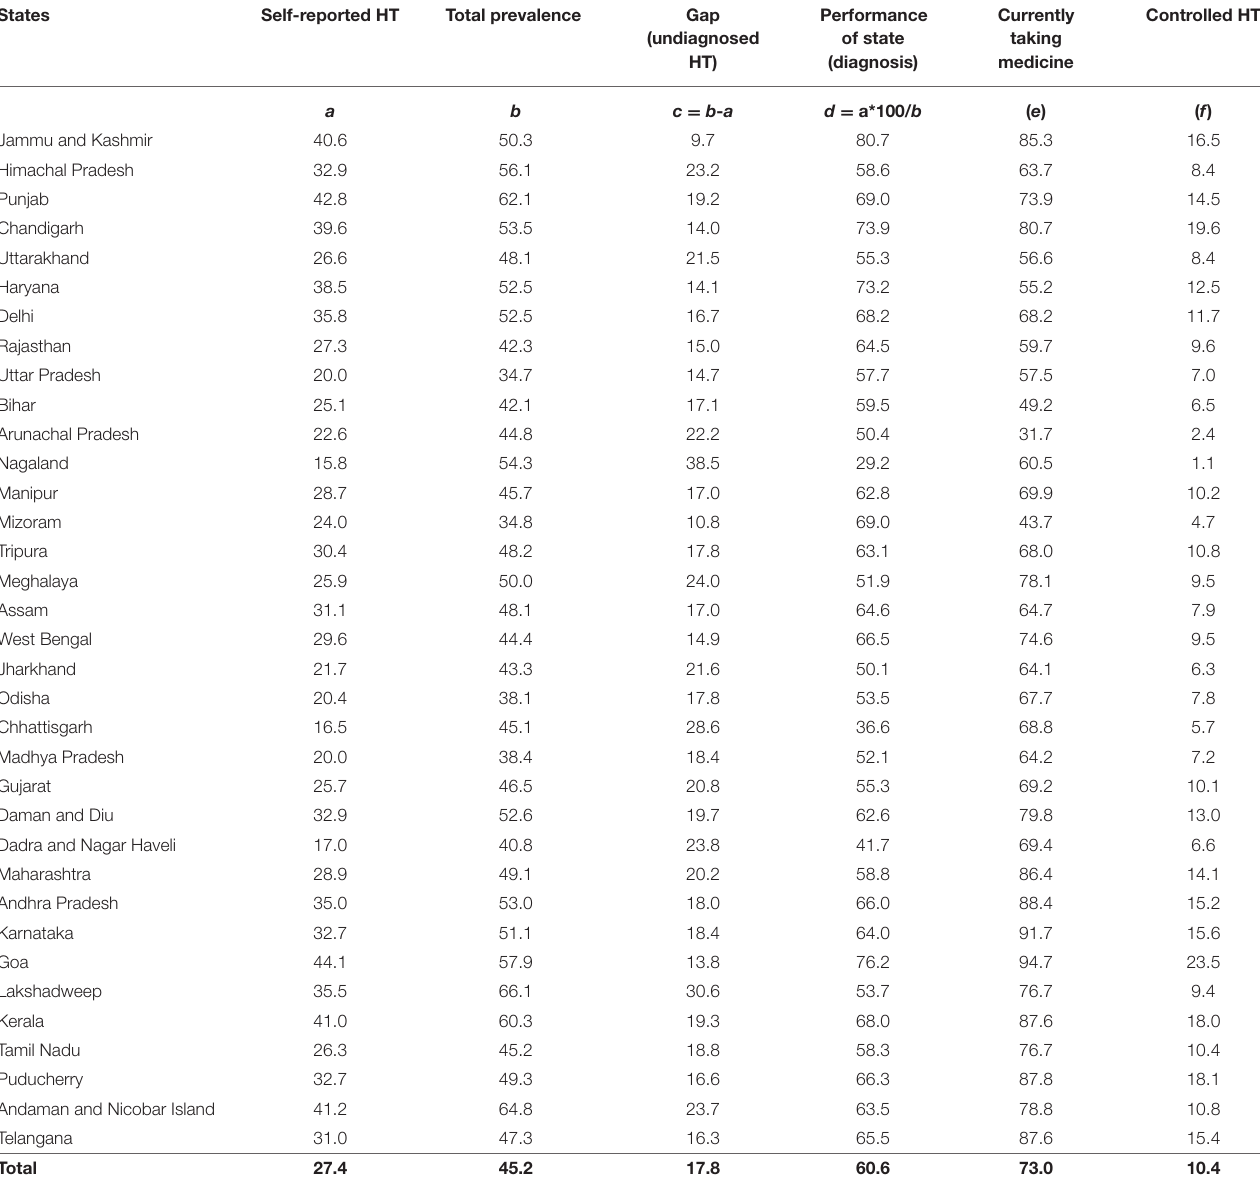
TABLE 4 | State-wise prevalence of self-reported, undiagnosed, overall, and controlled hypertension among older adults in India, LASI, 2017–18. States Self-reported HT Total prevalence Gap